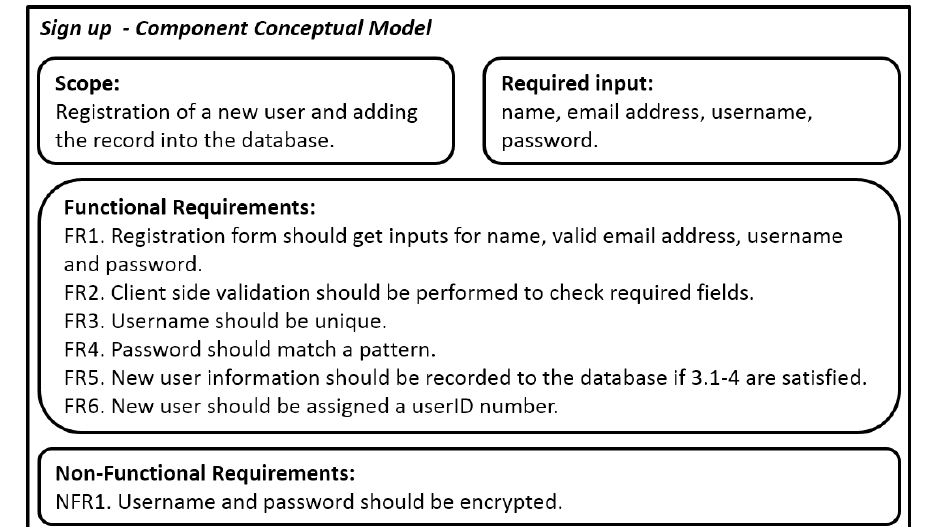
Figure 5. Sample CCM definition for sign up component.